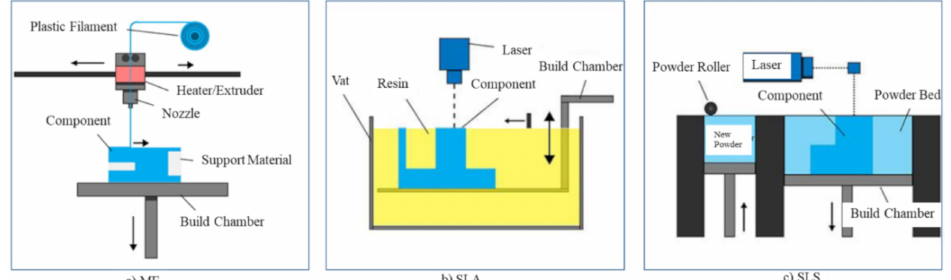
Figure 1. Additive manufacturing (AM) technologies: ( a ) material extrusion (ME), ( b ) stereolithography (SLA), and ( c ) selective laser sintering (SLS) processes.